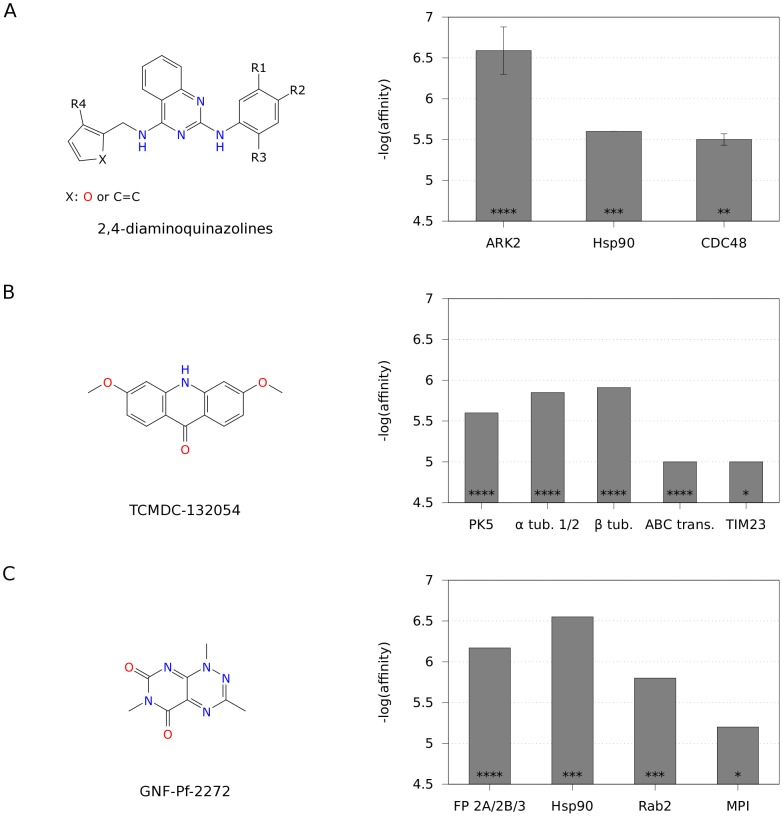
Selection of diverse multi-target profiles.The structures shown correspond to (A) the core scaffold of a set of 19 2,4-diaminoquinazolines, (B) TCMDC-132054, and (C) GNF-Pf-2272. The corresponding distributions of predicted affinities over multiple targets are provided on the right-hand side. For the set of 2,4-diaminoquinazolines (A), average predicted affinities are shown, with error bars giving the standard deviation over all compounds. Asterisks within the bars indicate the priority class of the respective target (‘****’ = high priority, ‘***’ = high affinity, ‘**’ = enriched, ‘*’ predicted target). Targets of the same orthologous group are joined to a single bar.